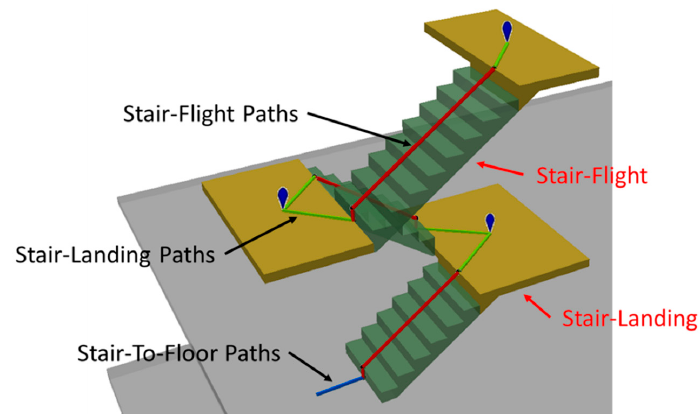
Figure 2. Stair-associated paths suggested by i-GIT [1].